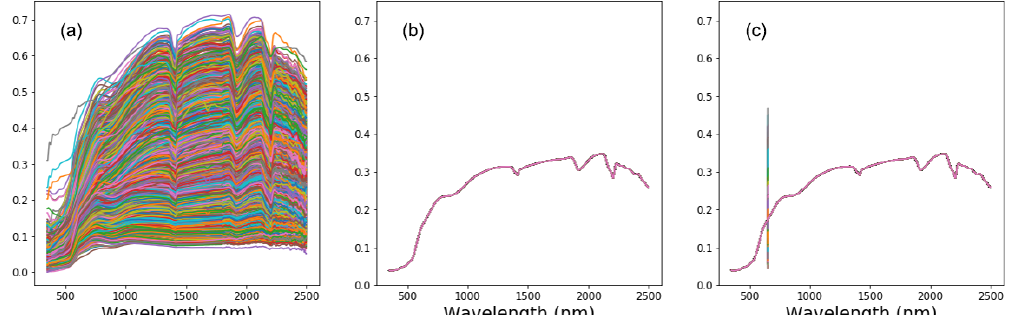
Figure 3. Illustration of the sensitivity analysis process, with (a) the validation spectra, (b) the overall average of the validation spectra and (c) the modified average of the validation spectra.